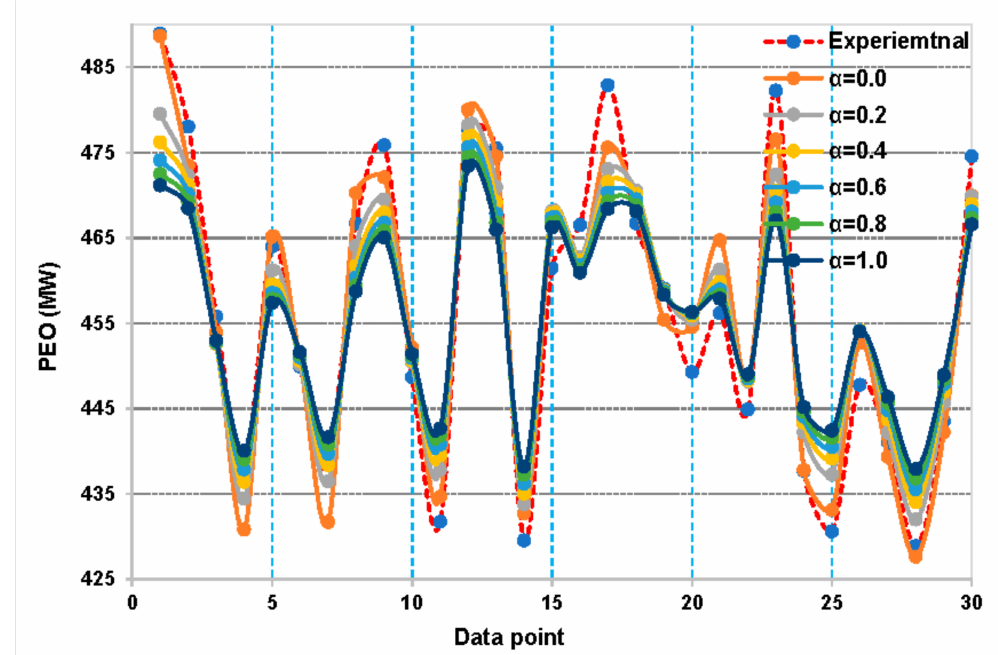
Figure 5. The trend of experimental readings and predictions made by Ridge regressor for the first 30 data points during training with different α values ranging from 0 to 1.0.